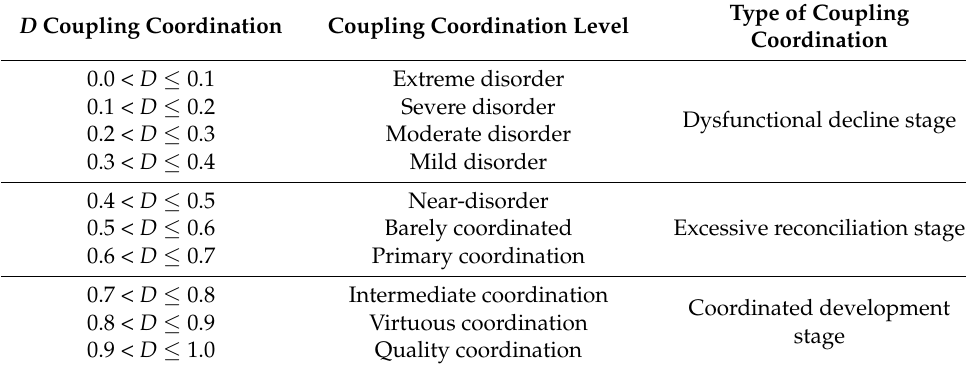
Table 2. WLF nexus coupling coordination level classification